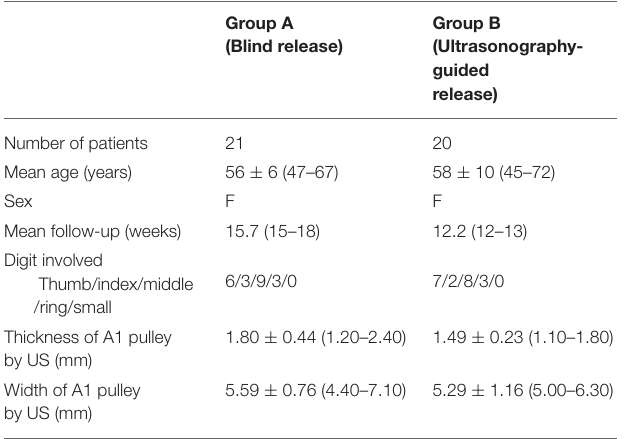
TABLE 1 | Demographics of patients * .